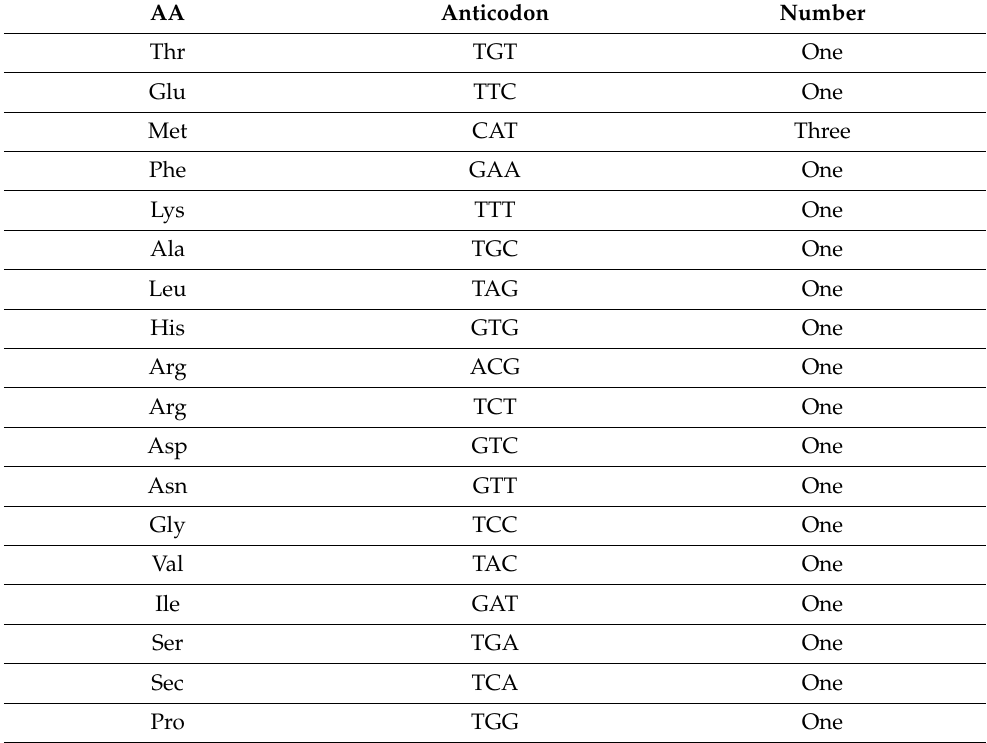
Table 5. tRNAs in the mitogenome of O. lanpingensis.